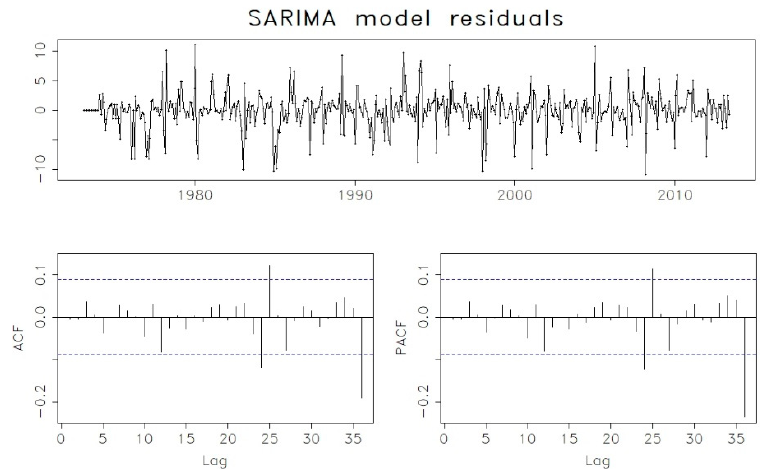
Figure 9. Residuals from the Seasonal Auto Regressive Integrative Moving Average (SARIMA) model.